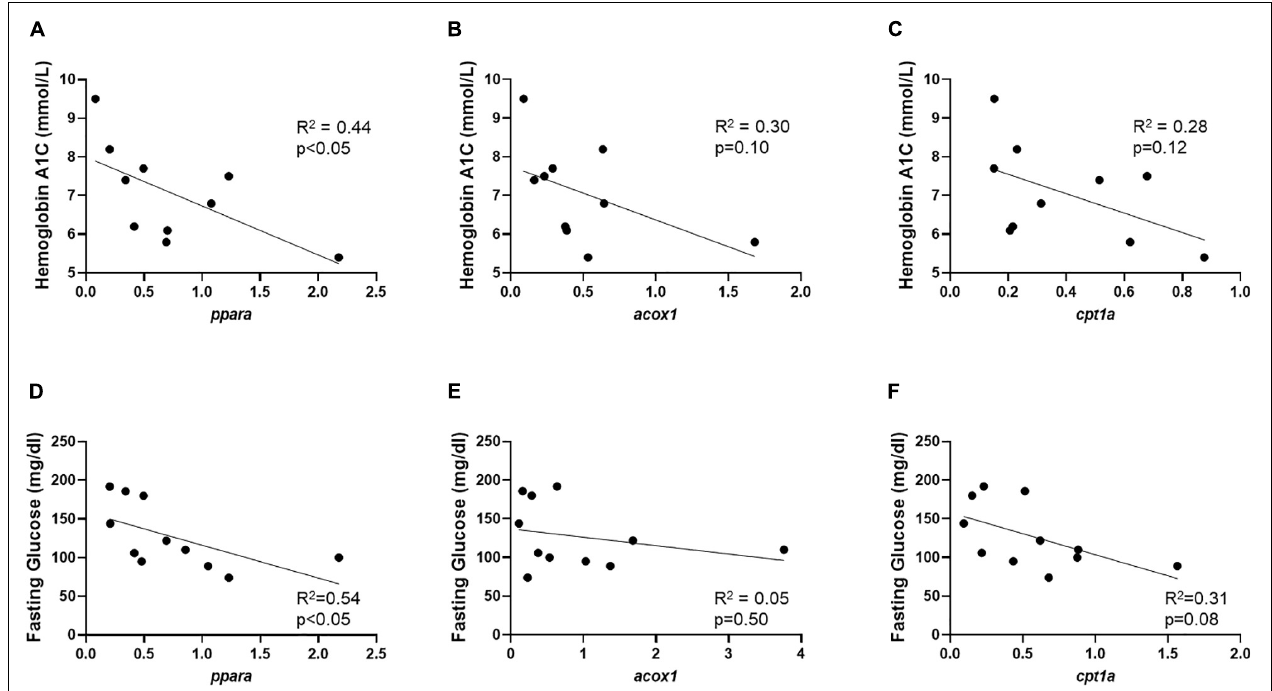
FIGURE 7 | Min lower extremity mRNA correlates with HbA1c and fasting glucose content. (A) Min-diseased lower extremity segment relative mRNA content demonstrates significant negative correlation between ppara ( p < 0.05, R 2 = 0.44, n = 10) compared to HbA1c content. (B,C) No significant correlation was observed between acox1 ( p = 0.10, R 2 = 0.30, n = 10) and cpt1a ( p = 0.12, R 2 = 0.28, n = 10) relative mRNA abundance compared to HbA1c content in Min-diseased lower extremity segments. (D) Min-diseased lower extremity segment ppara ( p < 0.05, R 2 = 0.54, n = 11) relative mRNA abundance shows significant correlation with fasting glucose. (E,F) No significant correlation was observed between fasting glucose and axoc1 ( p = 0.50, R 2 = 0.05, n = 11) or cpt1a ( p = 0.08, R 2 = 0.31, n = 11) relative mRNA